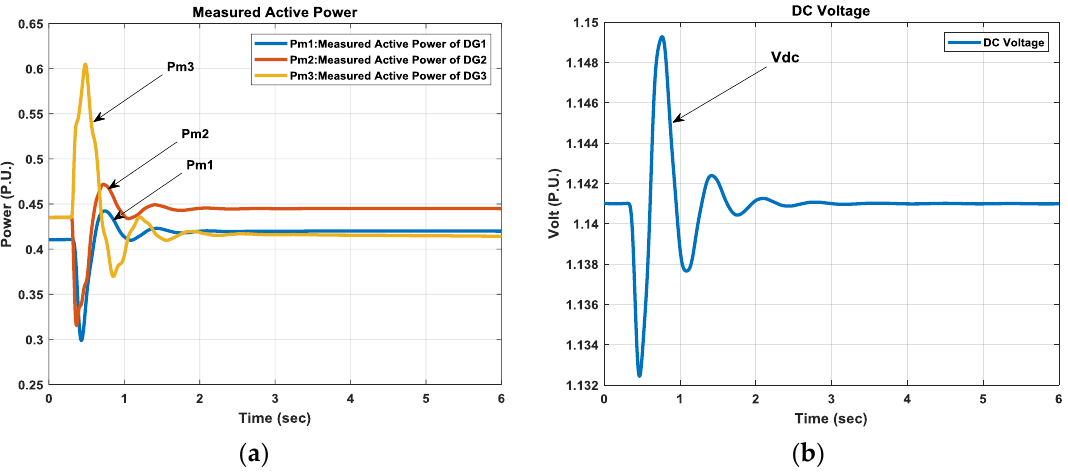
Figure 7. Microgrid response when a three-phase fault occurred at CPL bus. Figure 9. Microgrid response when the microgrid loses DG1.